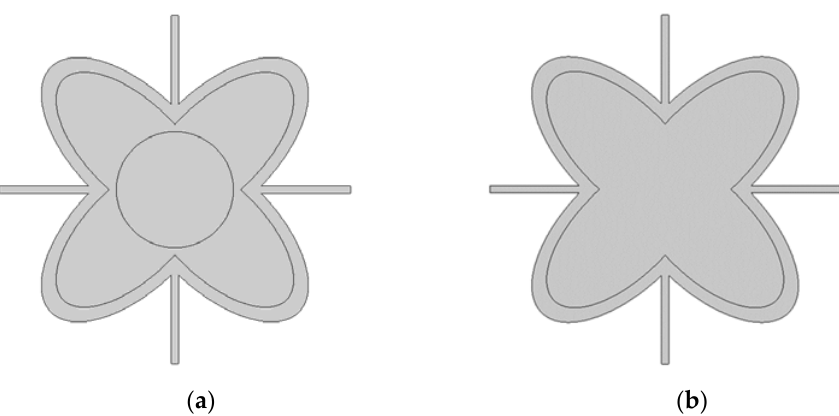
Figure 3. Representative element microstructure ( a ) with and ( b ) without circular inclusion.